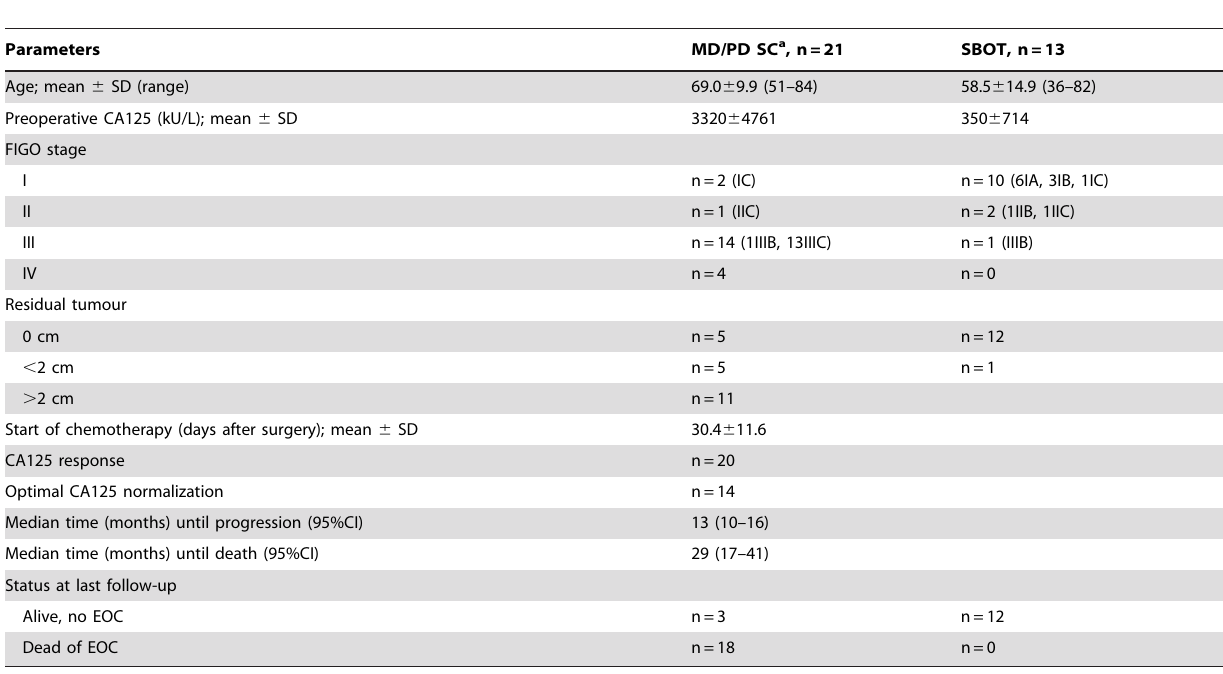
Table 2. Clinicopathological and laboratory information for patients selected for RT-qPCR analyses.